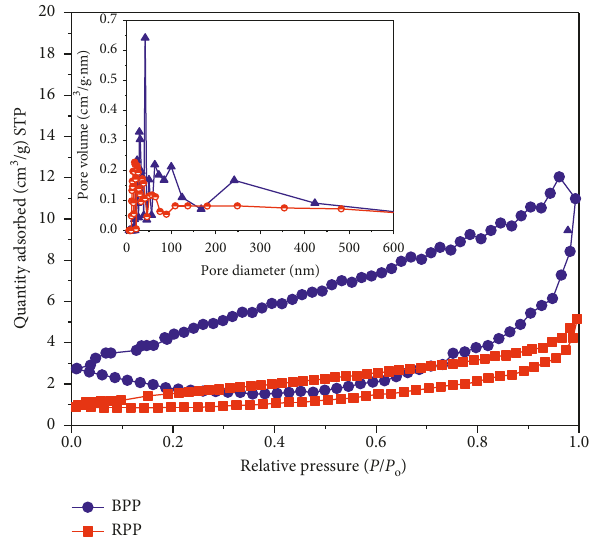
Figure 8: Nitrogen adsorption-desorption isotherms at 77K for RPP and BPP. Insets show the relation between pore volume and diameter for both adsorbents.